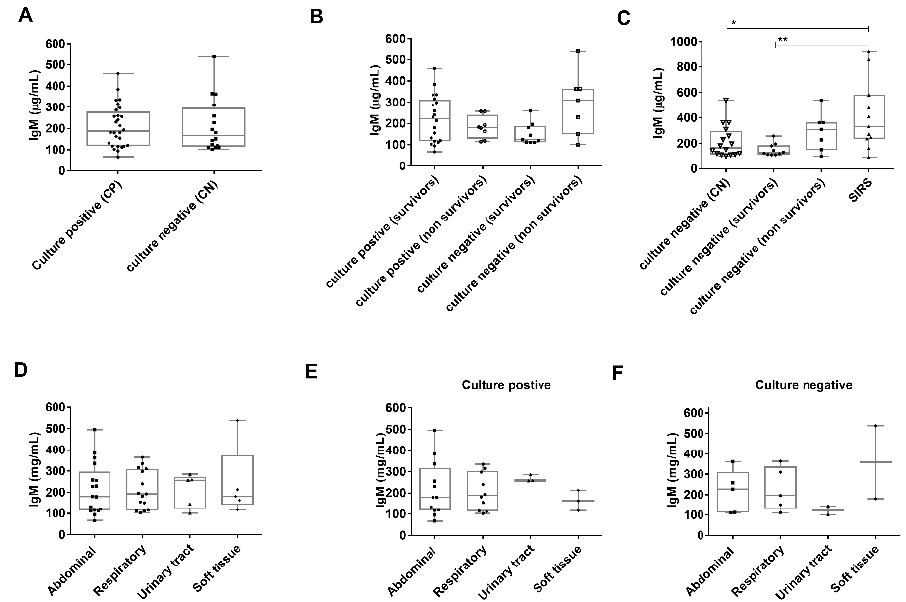
Figure 2. IgM levels in the sepsis groups. ( A ) IgM levels are not significantly different in culture- positive compared with culture-negative sepsis ( p = 0.78), nor for ( B ) culture-positive or negative survivors compared with non-survivors. ( C ) IgM levels were significantly different comparing cul- ture-negative sepsis and SIRS ( p = 0.025) and culture-negative sepsis survivors and SIRS ( p = 0.0055). No significant differences in IgM levels were observed when comparing sepsis ( D ) site of infection, nor for ( E ) culture-positive or ( F ) culture-negative site of infection. Boxes represent medians and inter quartile ranges, whiskers represent range. Individual values are overlayed on the plots. P val- ues * p < 0.05, ** p < 0.01, were determined by one-way ANOVA and Mann Whitney test.